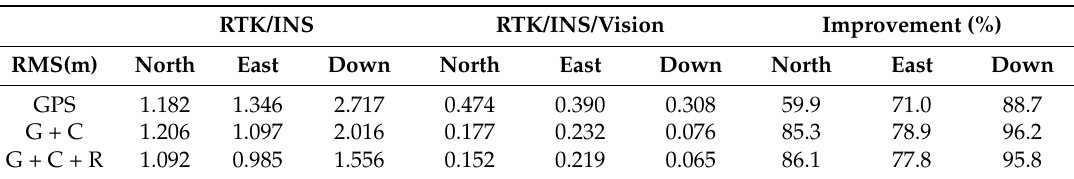
Table 2. Root mean square (RMS) of the position differences of the tightly coupled RTK/INS and RTK/INS/Vision integration with respect to the reference for the GPS, GPS + BDS (G + C), and GPS + BDS + GLONASS (G + C + R) systems.